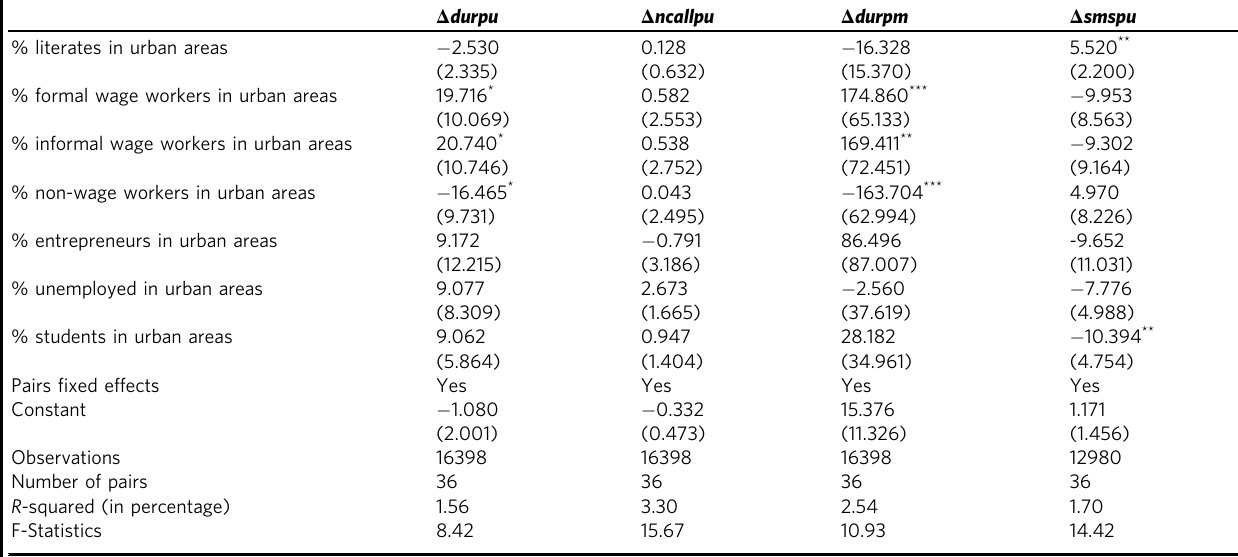
Table 4 Heterogeneity with respect to the characteristics of the incoming municipality-OLS estimates.